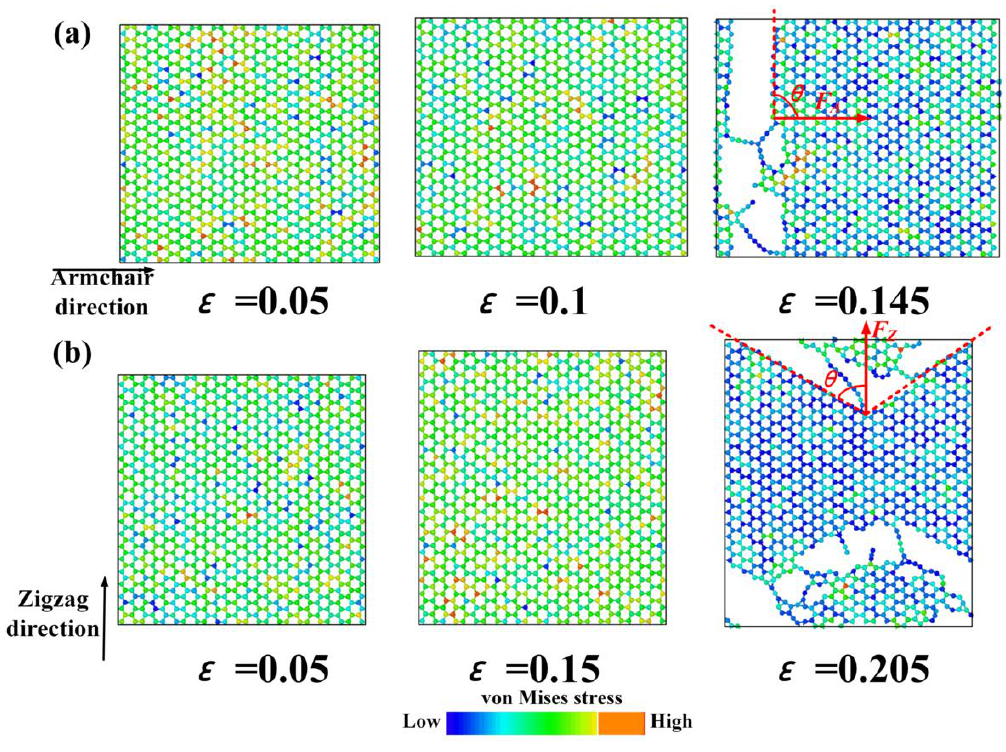
Figure 4. The fracture process and distributions of von Mises along: ( a ) the armchair direction and; ( b ) the zigzag direction.